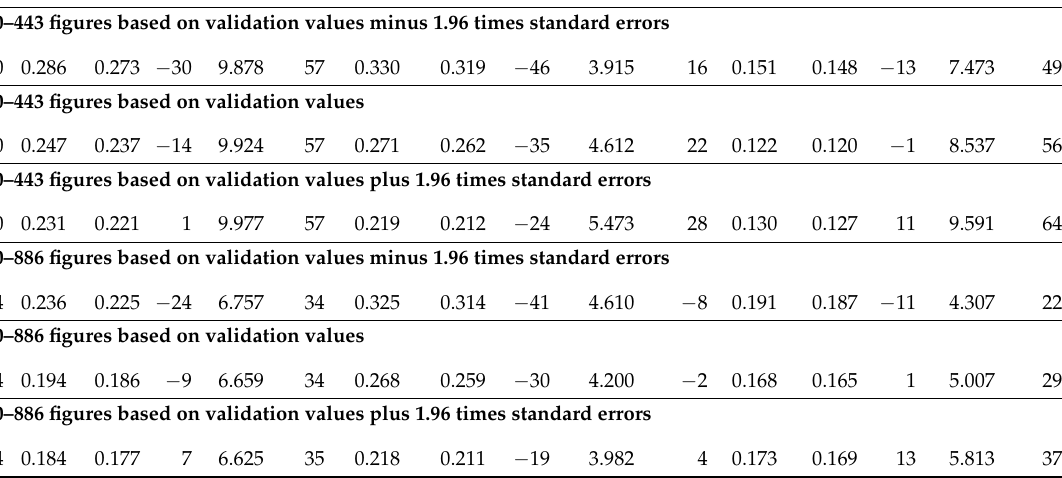
Table A7. Out-of-sample validation figures of the derived OLS proxy functions of BEL under 150–443 and 300–886 after the final iteration based on three different sets of validation value estimates. Thereby emerges the first set of validation value estimates from pointwise subtraction of 1.96 times the standard errors from the original set of validation values. The second set is the original set. The third set is the addition counterpart of the first